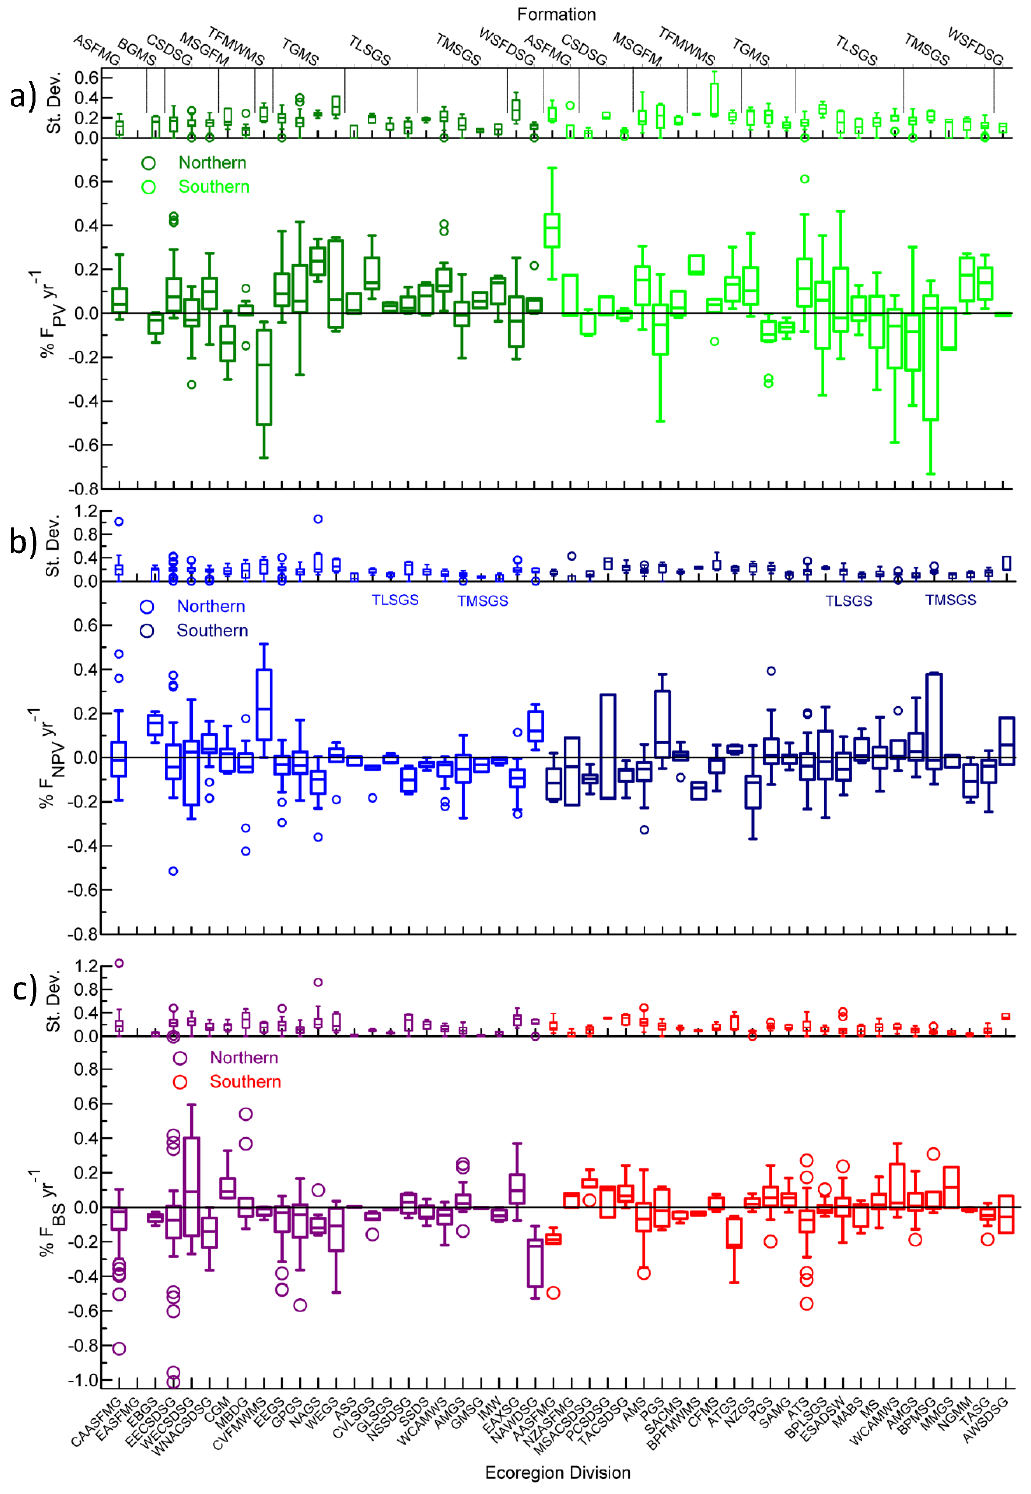
Figure 8. Fence box plots showing the median, upper and lower hinges and upper and lower fences of the average slope of the regression trend line from 2001–2018 for fractional cover within WGT vegetation divisions (listed in Table A2). ( a ) F PV ; ( b ) F NPV ; and ( c ) F BS .